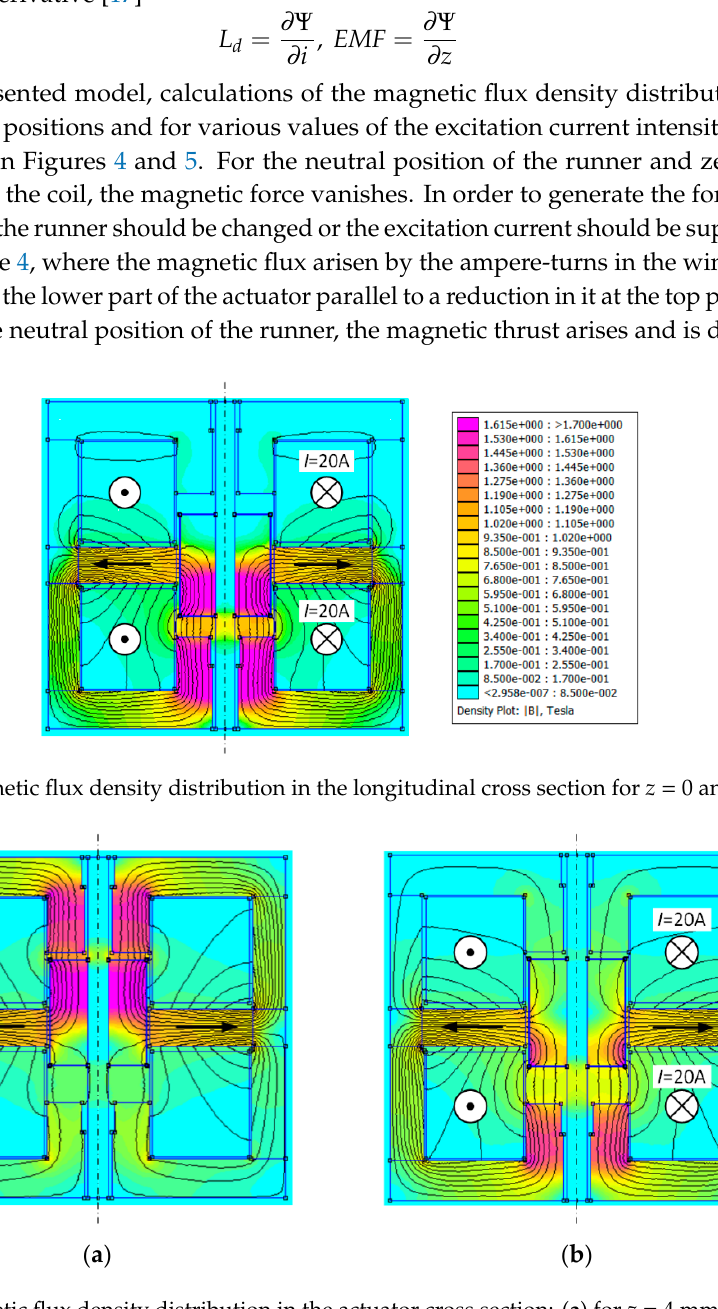
Figure 5. Magnetic flux density distribution in the actuator cross section: ( a ) for z = 4 mm and I = 0 A, ( b ) for z = 4 mm and I = 20 A.